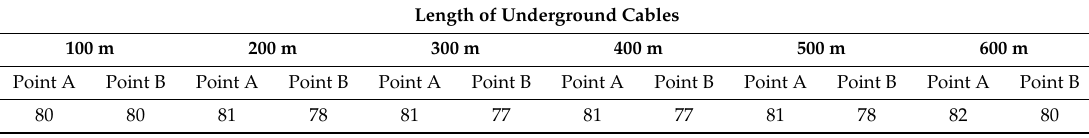
Figure 47. A 600 m underground cable. Table 8. Maximum overvoltage (kV) at point A and B, where the current of the lightning strike to point A is 40